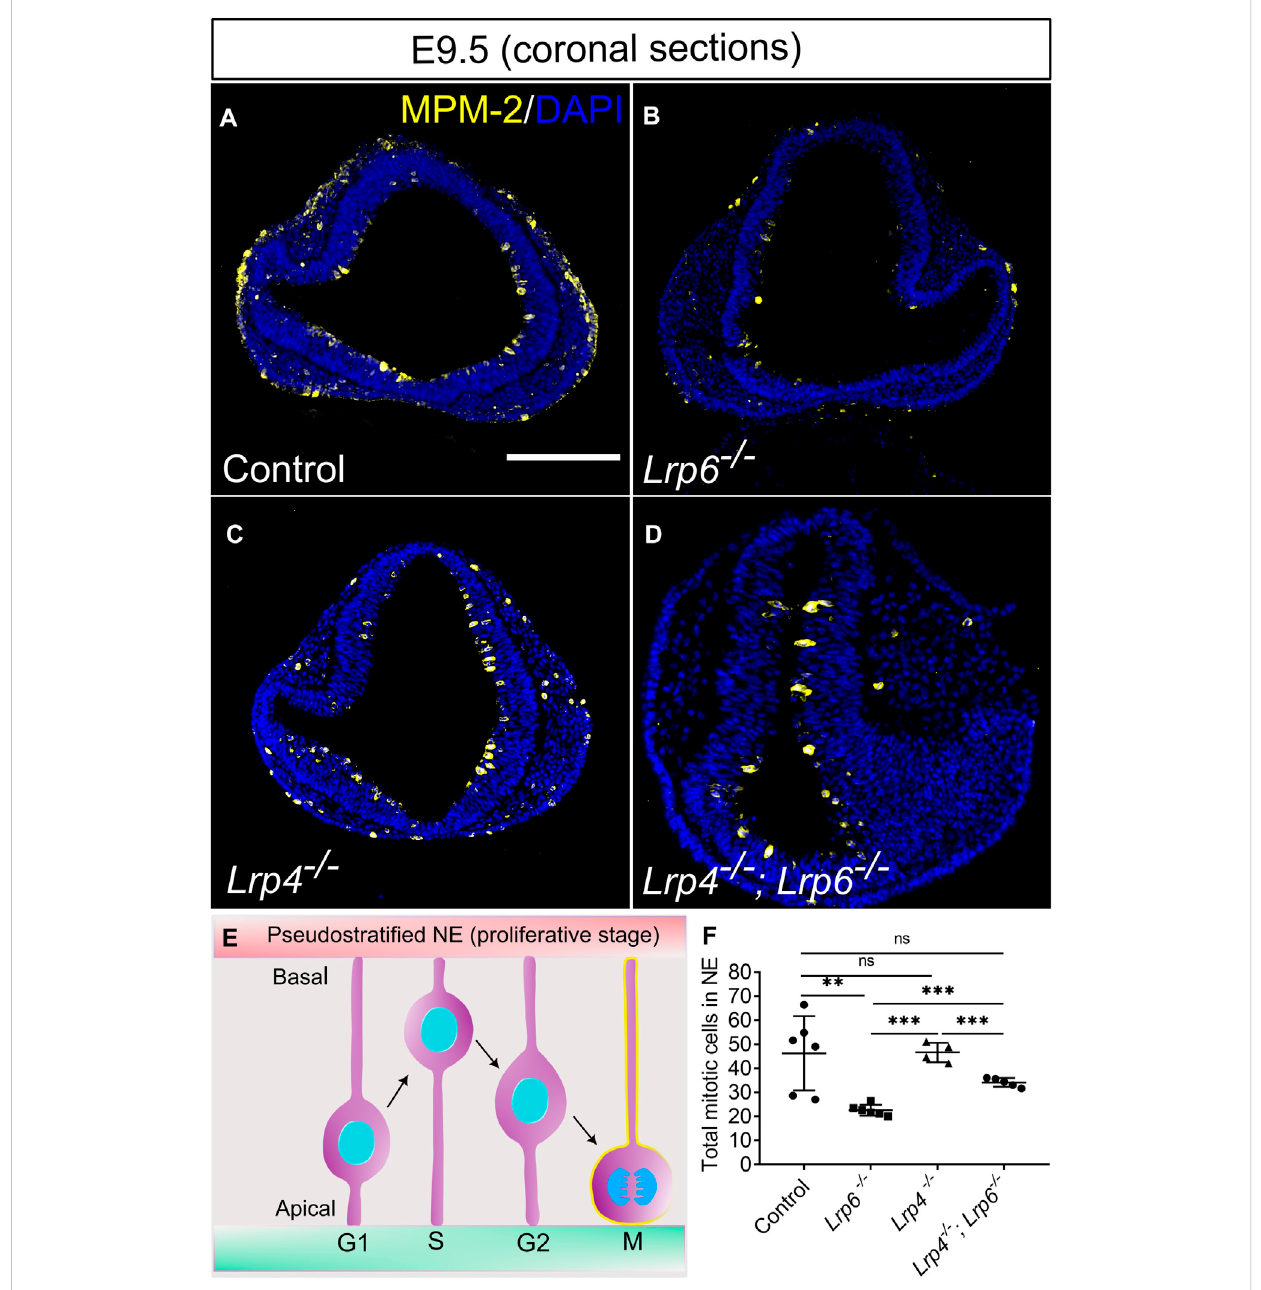
FIGURE 4 Decreased mitotic activity in LRP6-de fi cient neuroepithelium is rescued by ablation of LRP4. (A – D) Immunostaining for the mitosis marker MPM-2 (marksallcellinM-Phase)tovisualizeandquantifymitoticcellswithintheneuroepitheliumonE9.5coronalforebrainsections.MPM-2positivecellswere detected atthe apical side ofthe neuroepitheliumfacing theventricle [depicted in theschematic, (E) ]in wild-type controls (A) and Lrp4 − / − embryos (C) in similarnumbers. Lrp6 − / − forebrainneuroepitheliumsectionsshowedsigni fi cantlylowernumbersofmitoticcells (B) comparedtowild-typecontrols and Lrp4 − / − single mutants. Lrp4 − / − ; Lrp6 − / − double mutants (D) had similar numbers of mitotic neuroepithelial cells as wild-type controls and therefore showed aclear rescue of mitotic activity compared to Lrp6 − / − single mutants. Scale bar: 200 μ m. (F) To quantify mitotic cells within the neuroepithelium, neural progenitor cells that stained positive for mitosis marker MPM-2 were counted manually on six coronal sections of the forebrain for each embryo. Number of embryos for each genotype: controls n = 6, Lrp6 − / − n = 6, Lrp4 − / − n = 4; Lrp4 − / − ; Lrp6 − / − n = 5; The mean values of MPM-2 cell count for each section was calculated and correlated to DAPI counts. Statistics: one-way ANOVA; NE: neuroepithelium. NE: